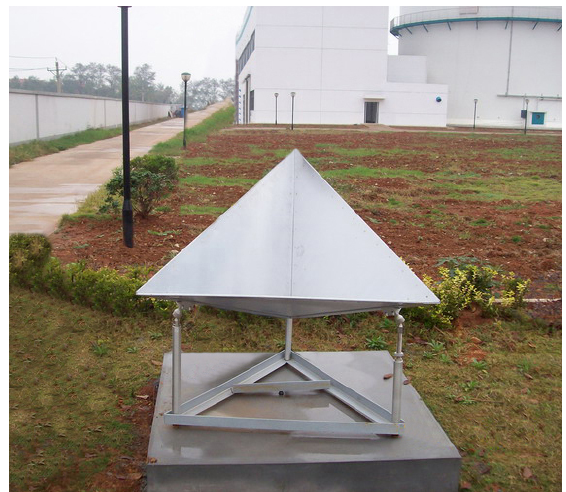
Figure 2. CR used in the